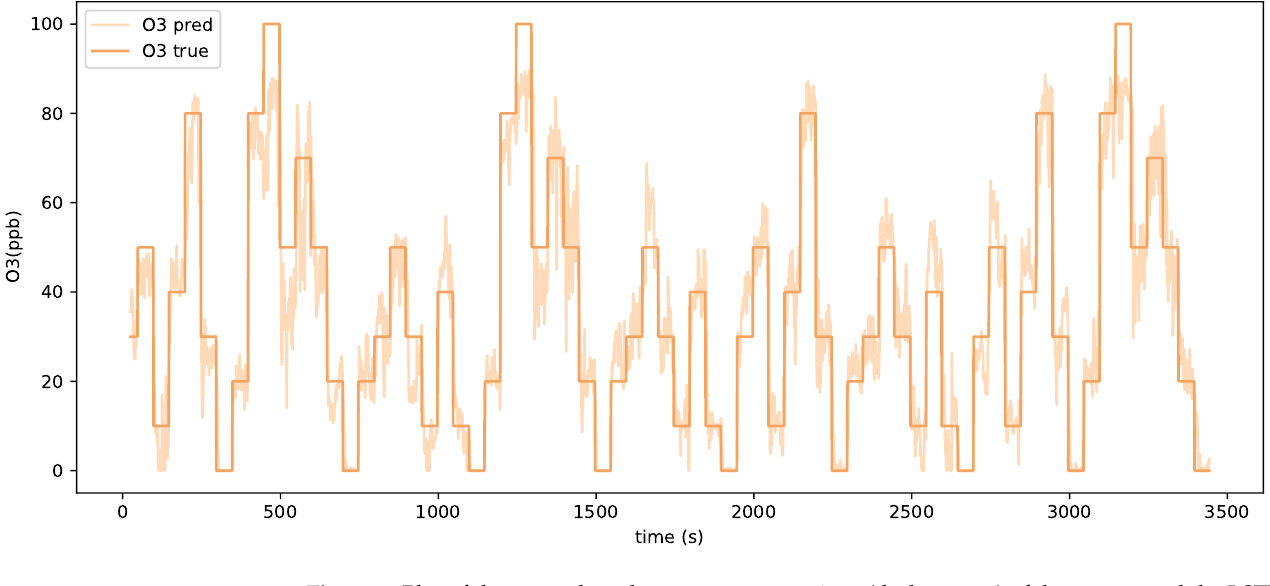
Figure 5. Plot of the ground-truth ozone concentrations (dark orange) of the test set and the LSTM model concentration estimates (light